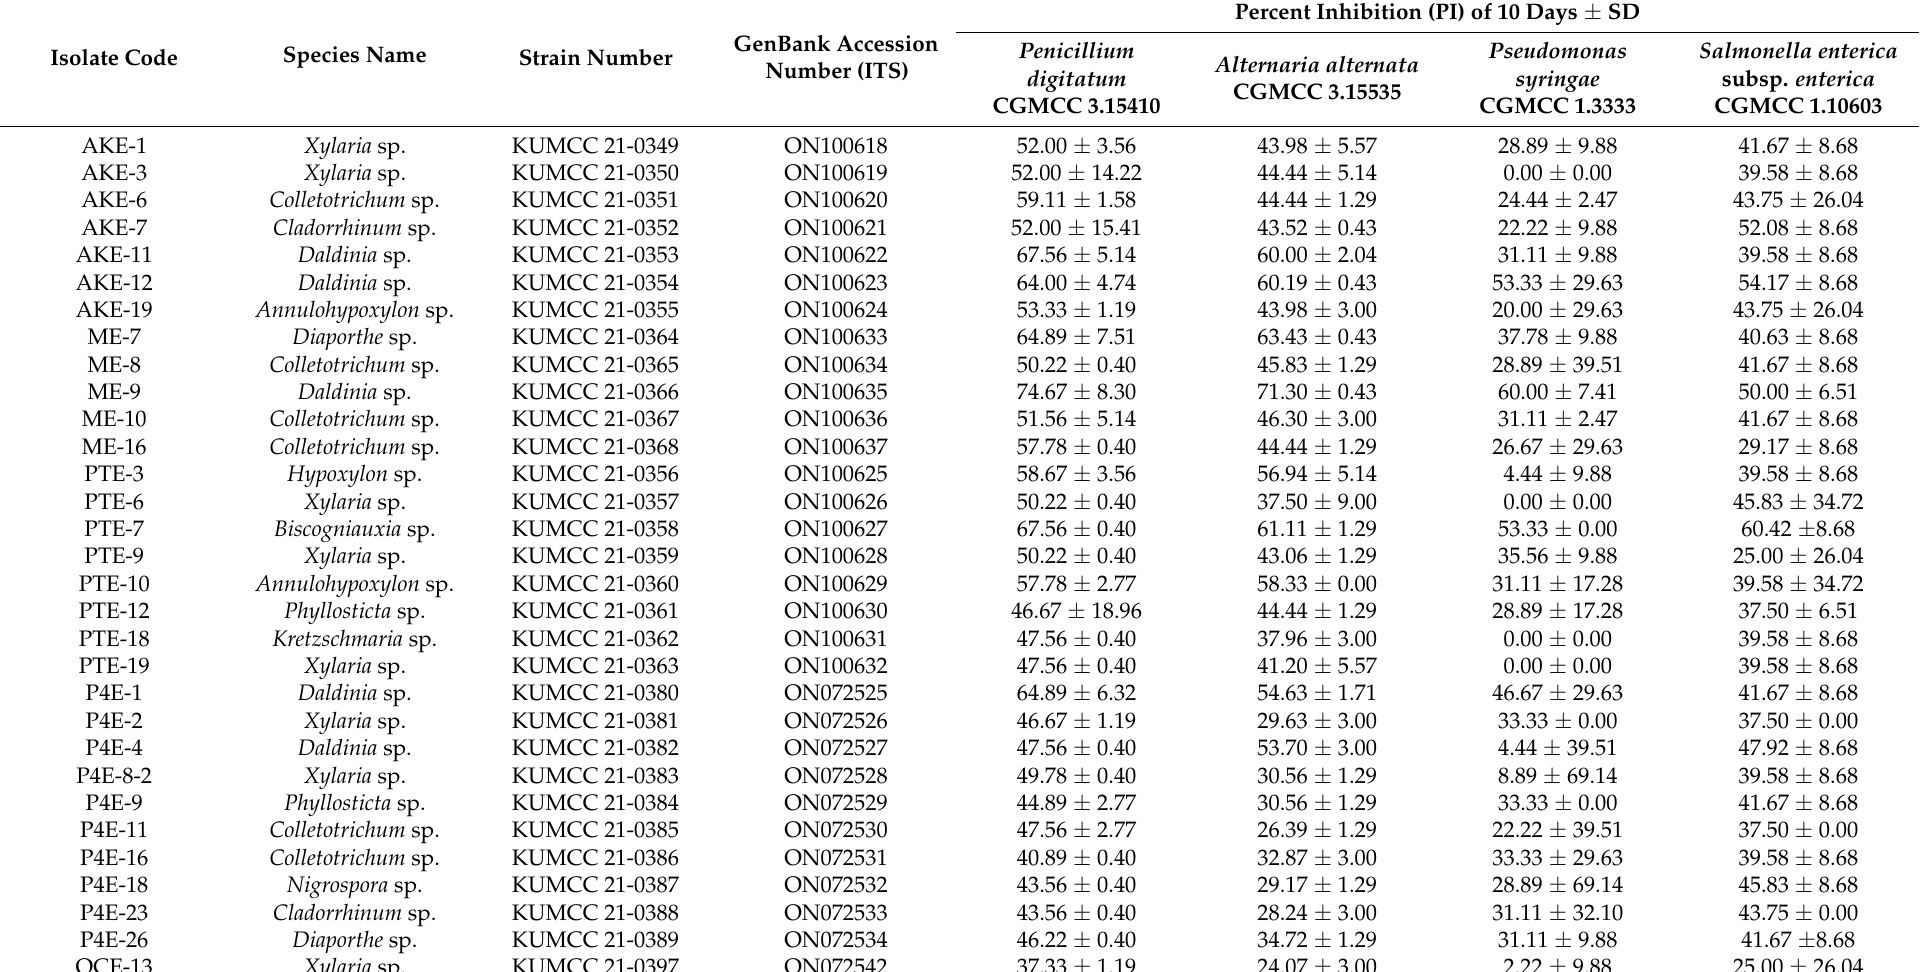
Table 5. Results of the dual-culture assay of 61 selected endophytes against the four pathogens. The type of fungal interaction for each isolate against each pathogen and the percentage of growth inhibition (I%) ± standard deviation (SD) is